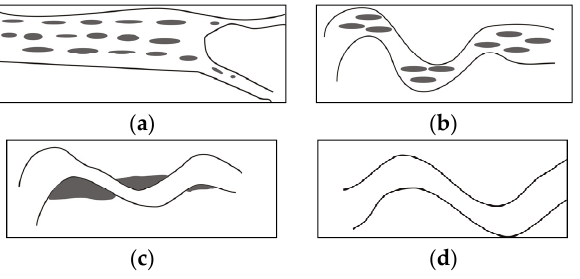
Figure 1. River planform classification developed by Brice. ( a ) Nonsinuous braided; ( b ) sinuous braided; ( c ) sinuous point bar; ( d ) sinuous braided canaliform.